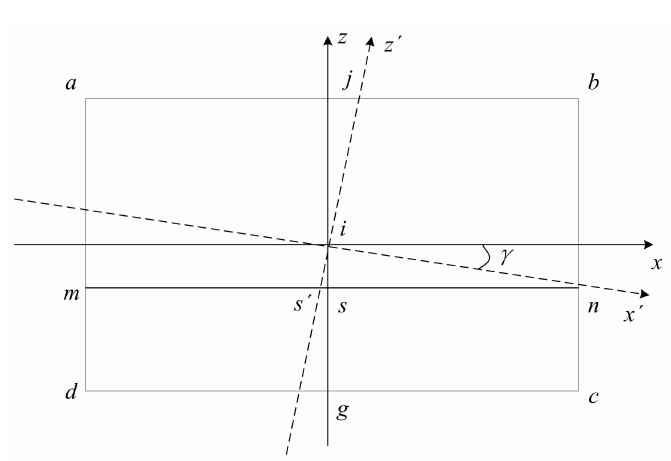
Figure 5. Geometric relationship between the SSL position and camera rolling